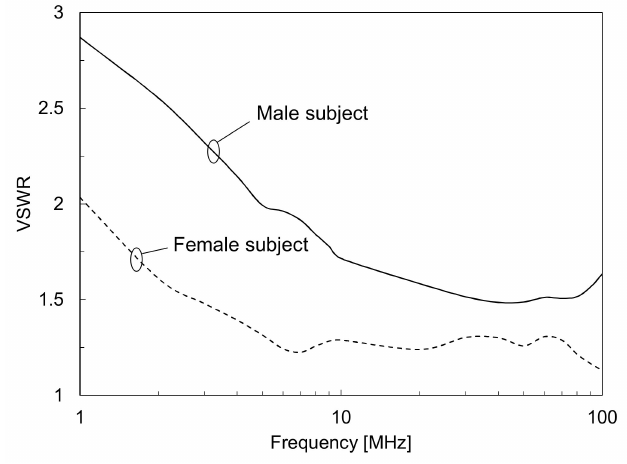
Figure 9. The worst values of the VSWR calculated using the input impedance characteristics obtained from the subject